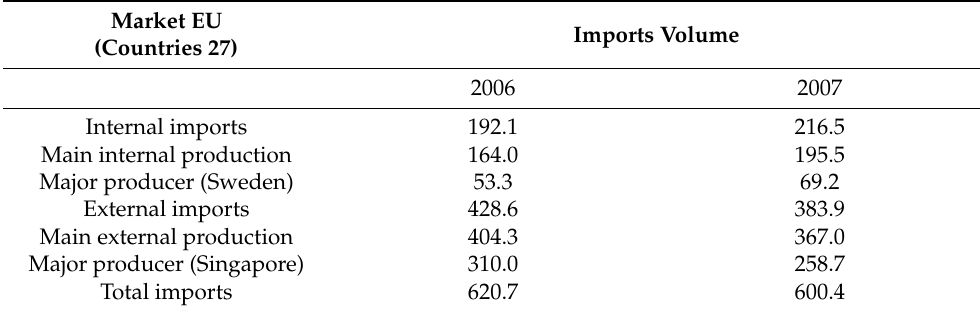
Table 7. European Union (EU): Total internal and external imports and production of biopolymers in